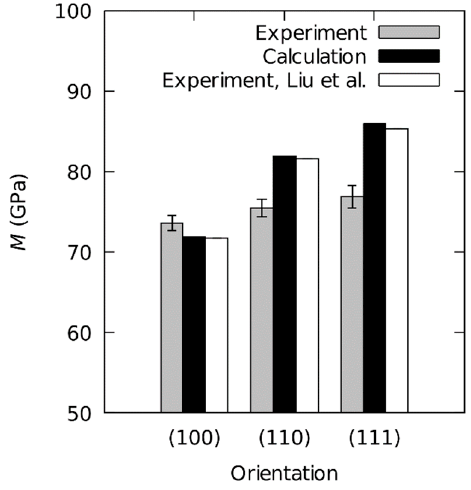
Figure 7. M for three crystallographic orientations of the aluminum single crystal. Grey shows this study (Experimental M ); black shows calculated M according to Equation (1); white shows Liu et al. [8] (Experimental M ).